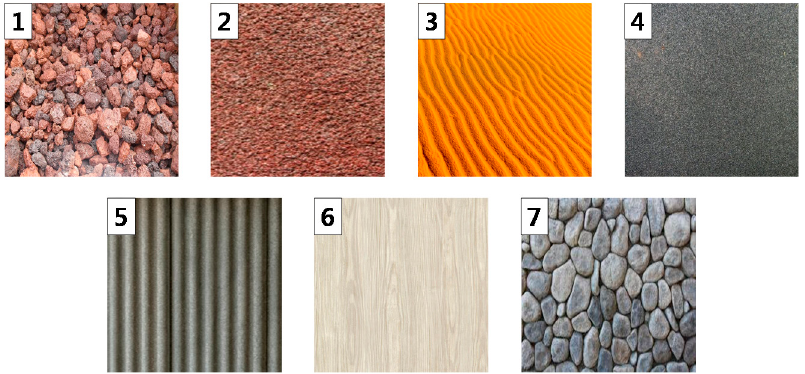
Figure 10. Seven prepared images for the third experiment.